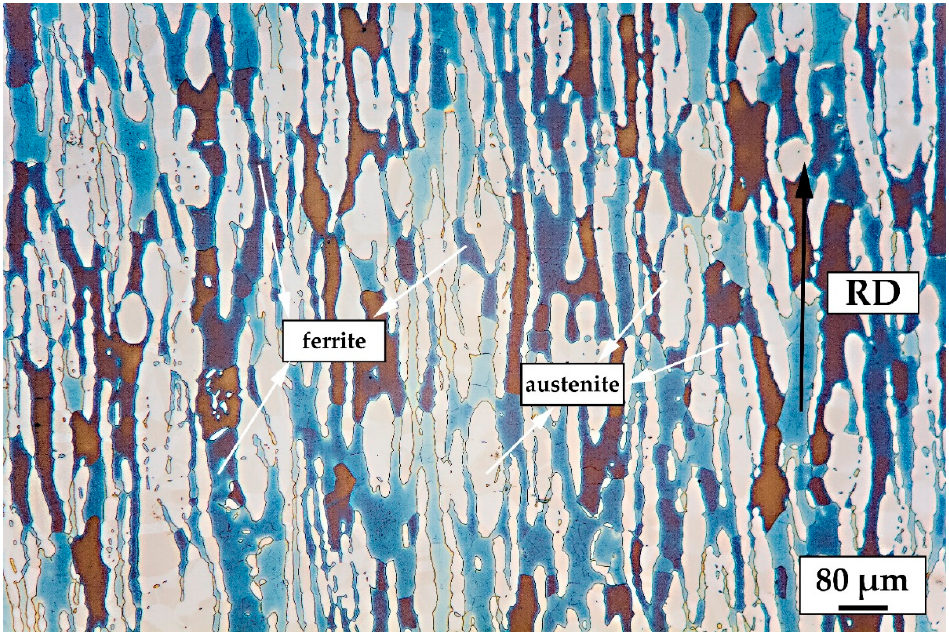
Figure 1. Microstructure of as received UNS S32750 bar.